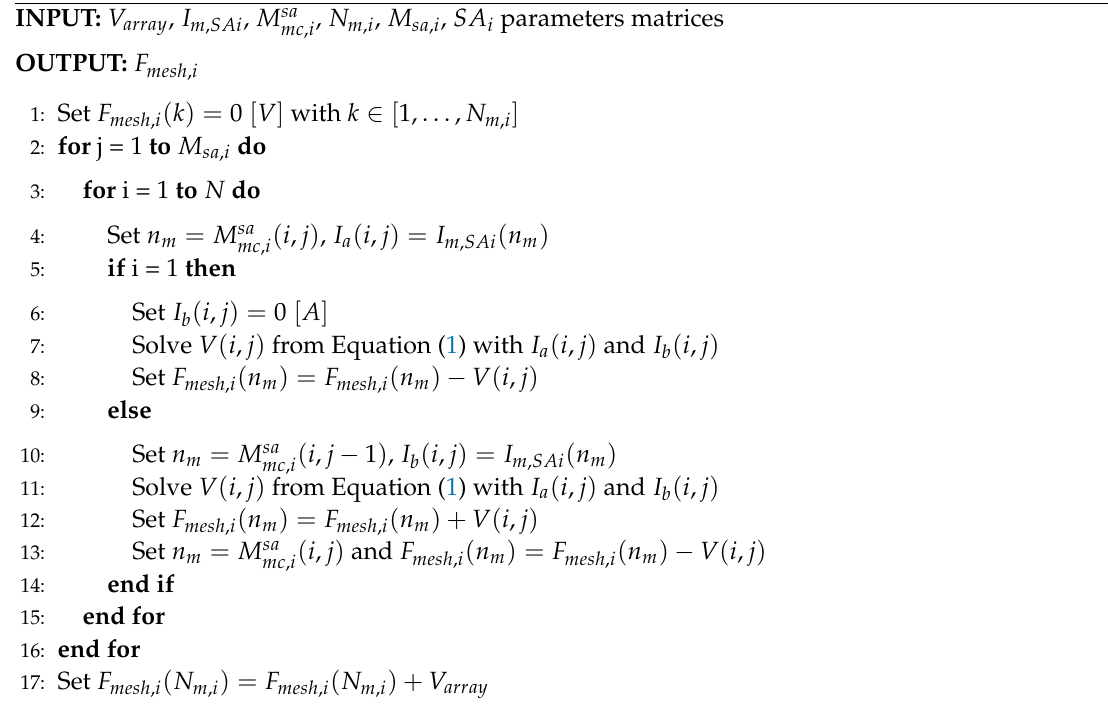
Algorithm 1 Calculate F mesh , i